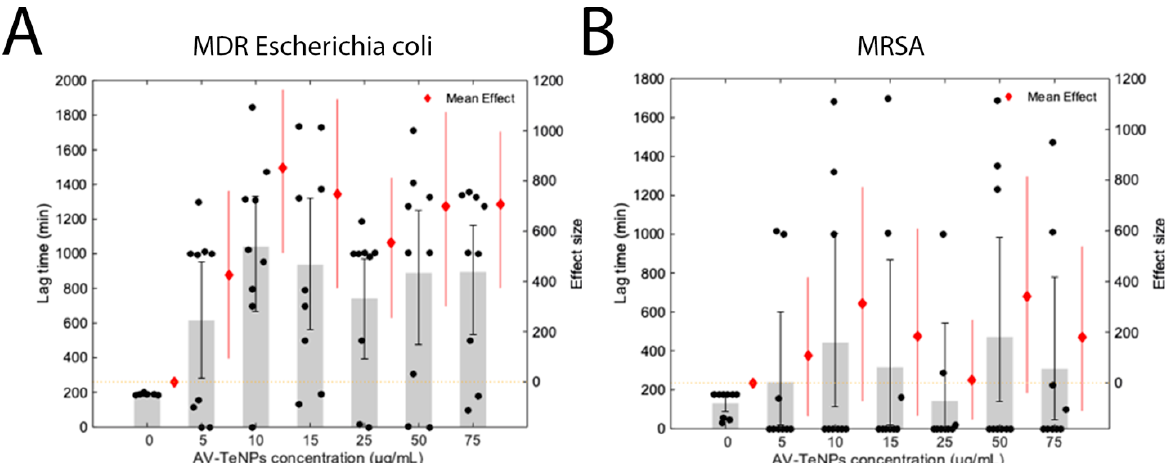
Figure A10. The growth rate and effect size against the shared control 0 concentration are shown in the above Cumming estimation plots for MDR Escherichia coli ( A ) and MRSA ( B ) experiments. Each mean difference is depicted as a diamond with 95% confidence interval indicated by the ends of the vertical error bars. Three measurements were taken for each biological replicate (denoted as a black bold dot, ● ).